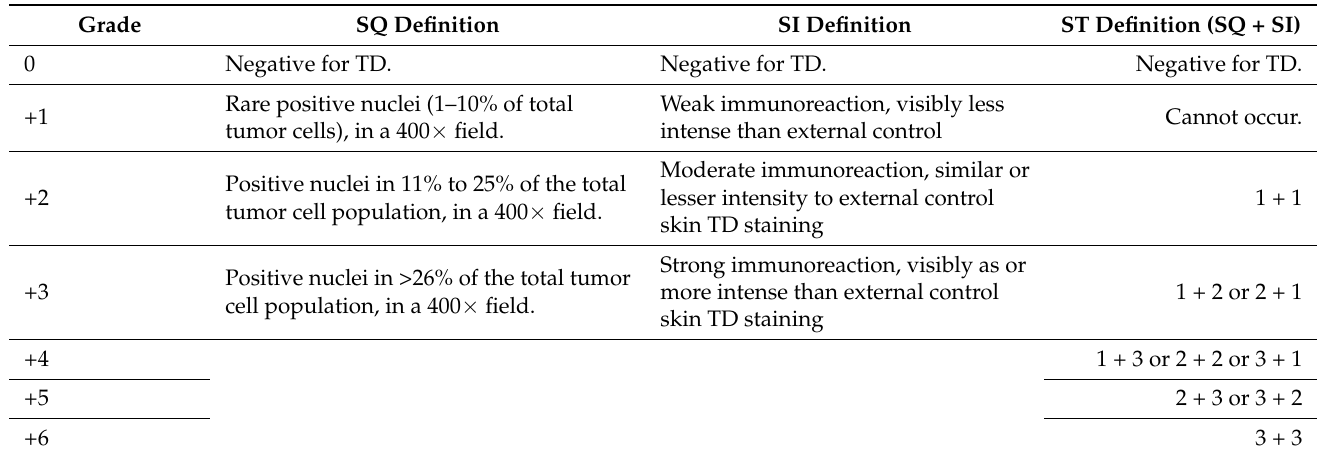
Table 1. Definitions for TD immunoreaction scores in RCC tumor tissue, i.e., the quantitative (SQ), qualitative (immunoreaction intensity) (SI) and overall (ST)